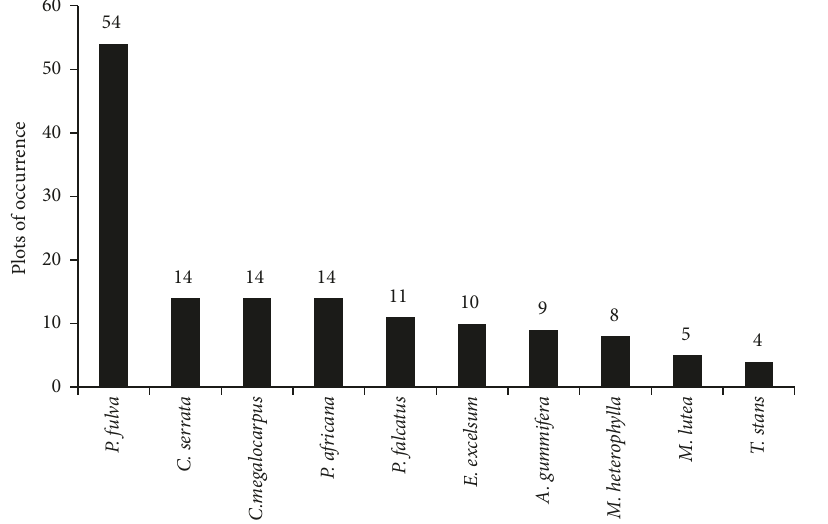
Figure 6: Distribution of 10 most populated woody species across plots in the self-regenerated secondary forest in Ruhande Arboretum, Huye,